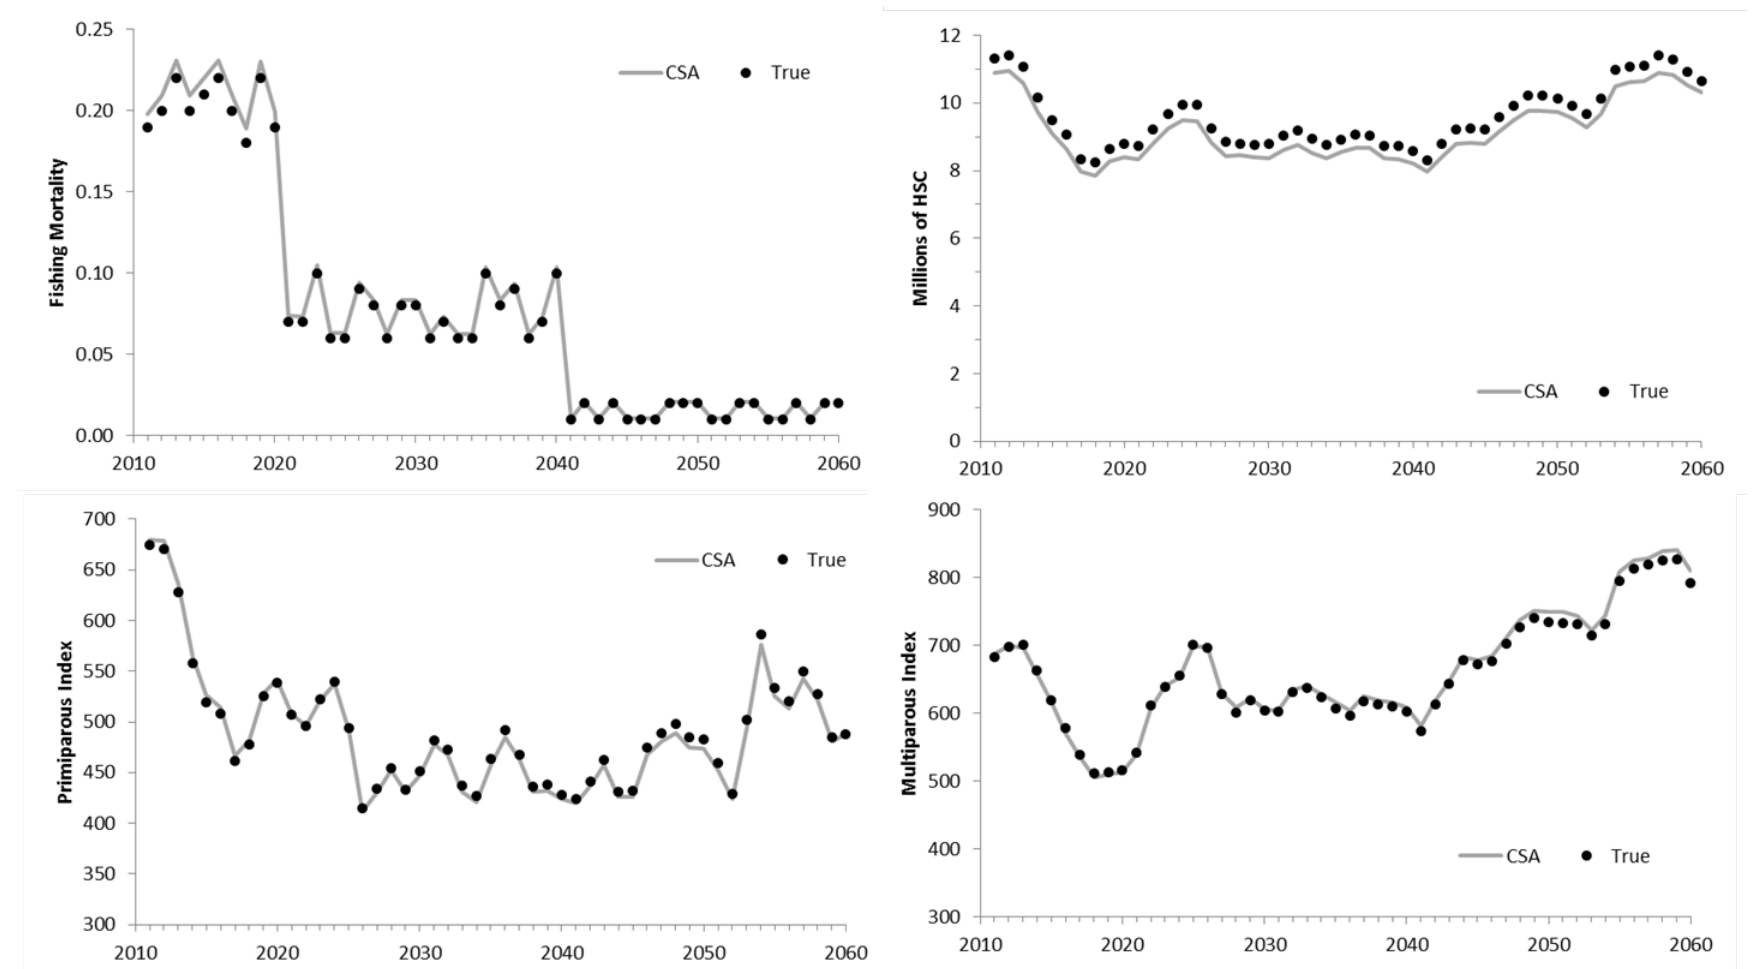
Comparison between simulated “true” data from the operating model and catch survey analysis (CSA) results for simulation